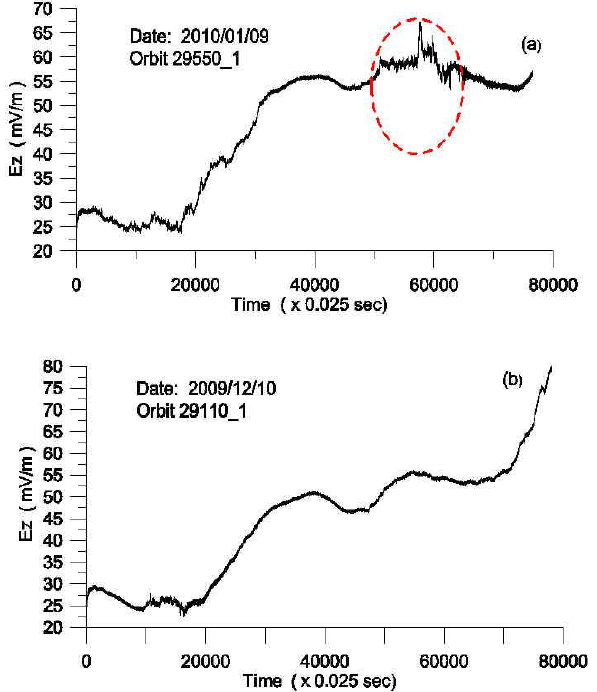
Fig. 2. Comparison of two different waveforms of the Ez electric field component, one (Fig. 2a) corresponding to the waveform pre- sented in Fig. 1 and the other (Fig. 2b) corresponding to a time Figure 2. Comparison of two different waveforms of Ez electric field component, one period where no earthquake occurred in the broad seismic region of (Fig. 2a) corresponding to the waveform presented to Fig.1 and the other (Fig. 2b) corresponding to a time period where no earthquake occurred in the broad seismic Haiti. region of Haiti.